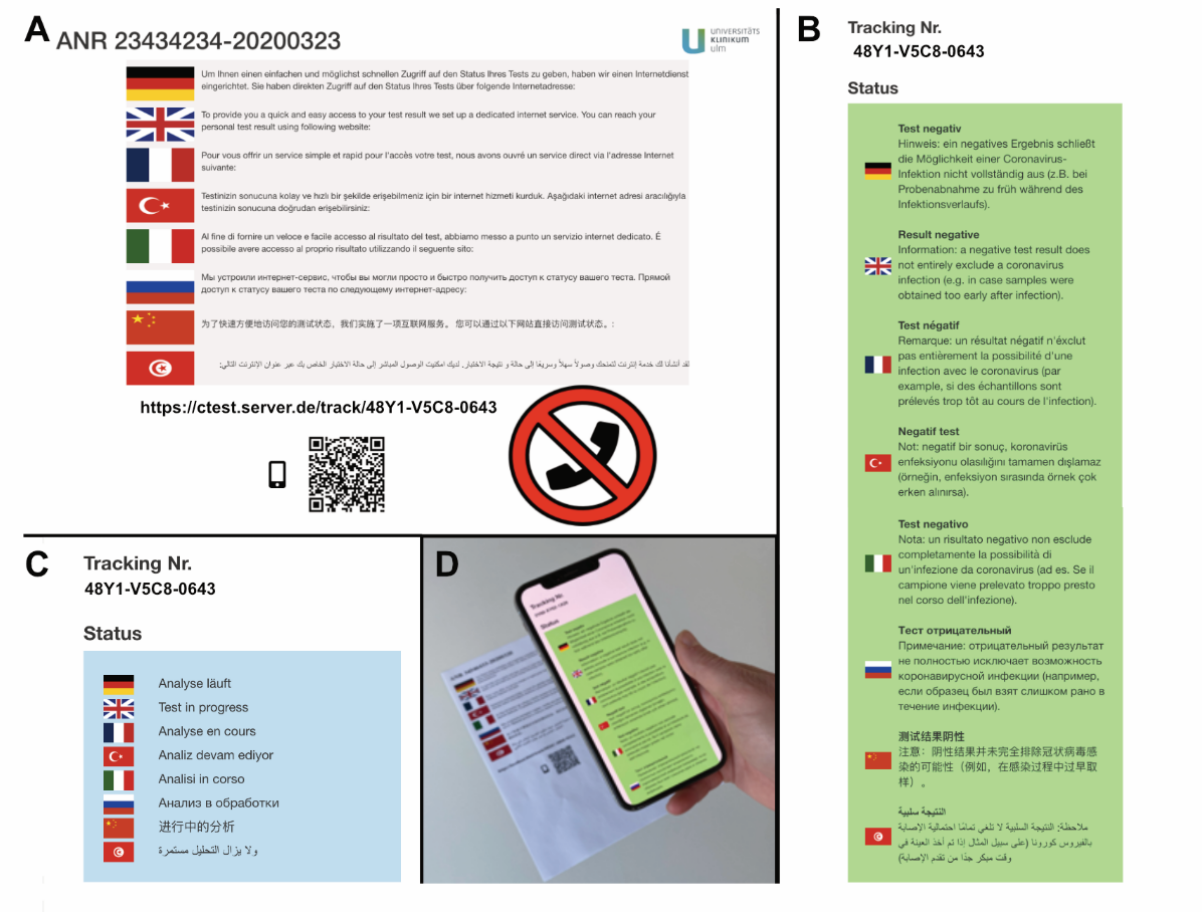
Figure 3. Information for testees. Information concerning access to the test status and its results are given in eight languages. (A) The information sheet handed over to testees informs them of how to access the COVID-19 test results online. (B) The test-specific URL links to a page that includes information about the test result (eg, negative test result) or (C) information stating that the test is still in progress. (D) Scanning the QR (Quick Response) code with a smartphone link takes the testee directly to the current test status or its